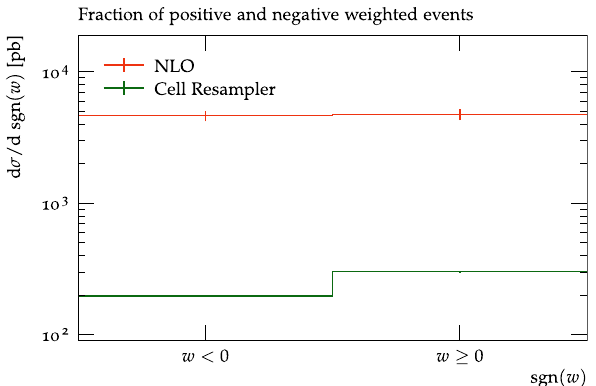
Fig. 5 Contributions of negative- and positive-weight events to the cross section according to the MC_XS Rivet analysis